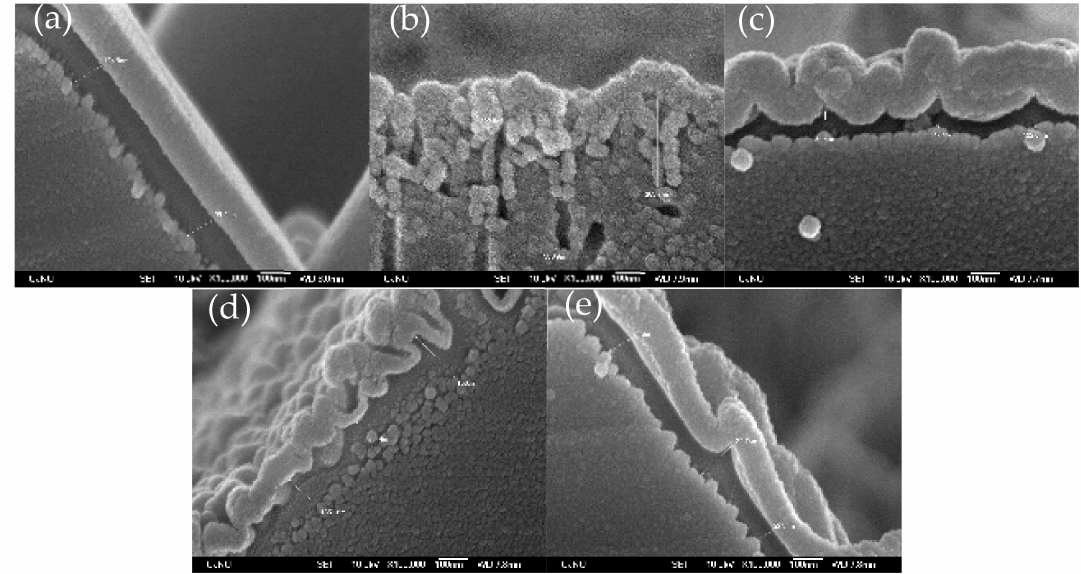
Figure 17. Cross-section SEM images of wafer after emitter formation process according to various etching process methods: